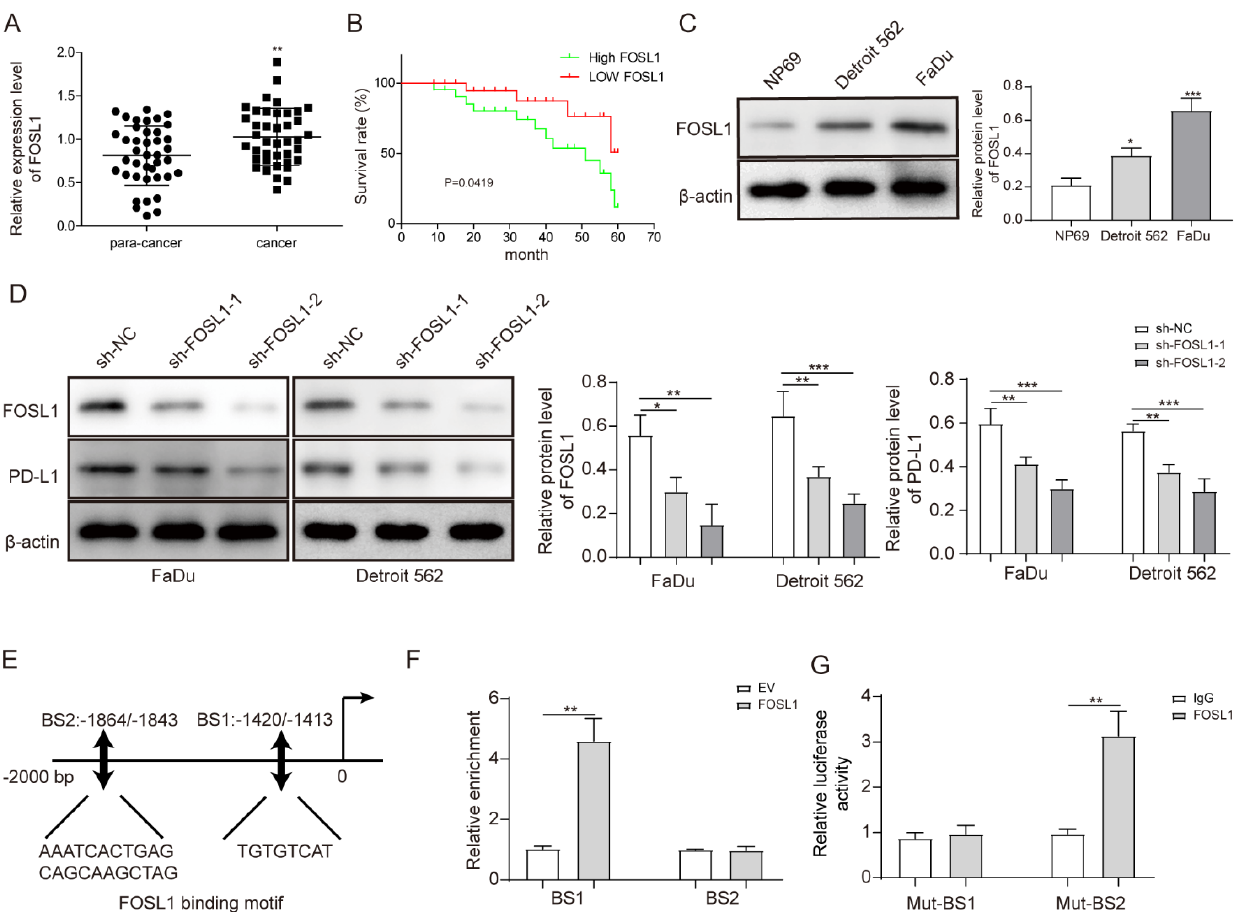
Figure 3. FOSL1 was highly expressed in HSCC cells and positively regulated PD-L1 expression by binding the PD-L1 promoter. ( A ) FOSL1 expression in HSCC and peri-carcinomatous samples was tested by RT-qPCR. ( B ) Correlation between FOSL1 expression and HSCC patients’ survival rate. ( C ) FOSL1 protein levels in HSCC cells measured by Western blot. ( D ) FaDu and Detroit 562 cells were transfected with shFOSL1-1 and shFOSL1-2, and the expression of FOSL1 and PD-L1 was detected by Western blot. ( E ) JASPAR was used to predict the binding sites between FOSL1 and the promoter of PD-L1. ( F , G ) ChIP and dual-luciferase reporter assays were used to further validate the regulatory relationship between FOSL1 and the PD-L1 promoter. * p < 0.05, ** p < 0.01, *** p < 0.001. Original Blots see Supplementary File Figure S1.